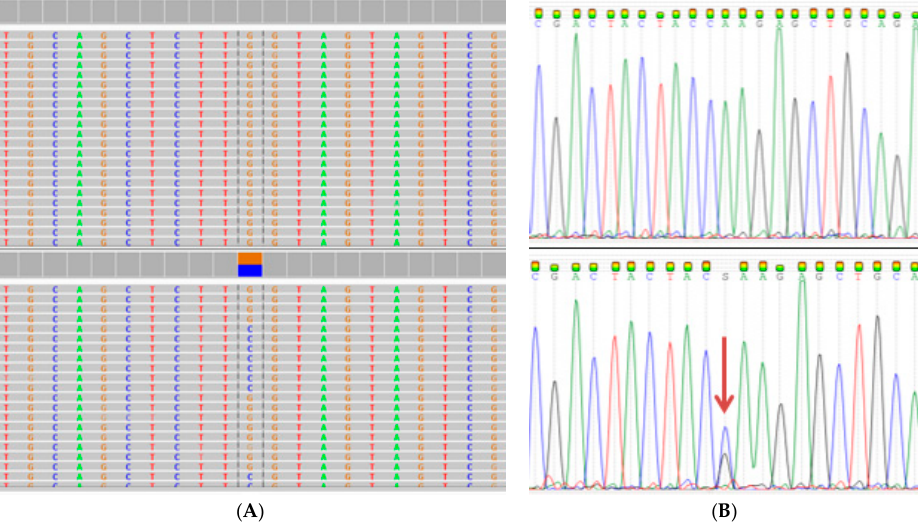
Figure 3. Detection of the MUC1 missense mutation Q85E (rs773704188, Refseq mRNA accession NM_002456.5) using WES ( A ); and visualized using the Integrative Genome Viewer software tool [36]. The C to G base change at nucleotide position 325 was confirmed by Sanger sequencing ( B ) as indicated by the arrow.